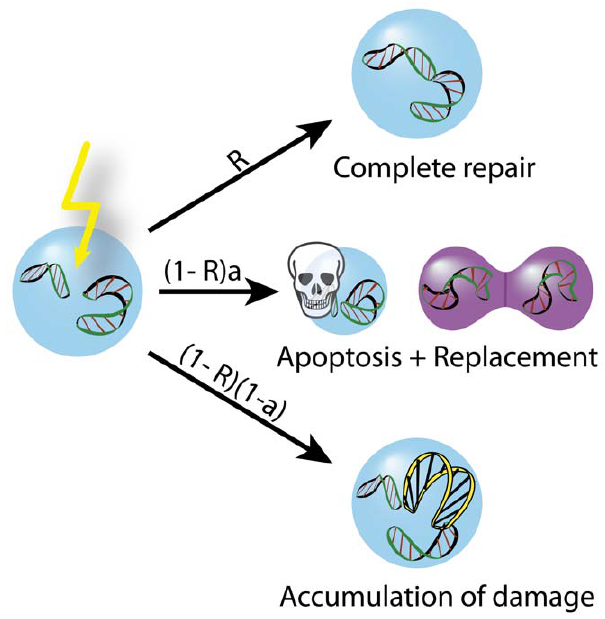
Figure 1. When a cell acquires DNA damage, it may respond in one of three ways: i) Complete repair of the damage with probability R , ii) Apoptosis with probability ( 1 { R ) a , in which case another cell divides to keep the number of cells constant, iii) Accumulation of the damage through a mutation, reducing the rate of repair to R ” D :